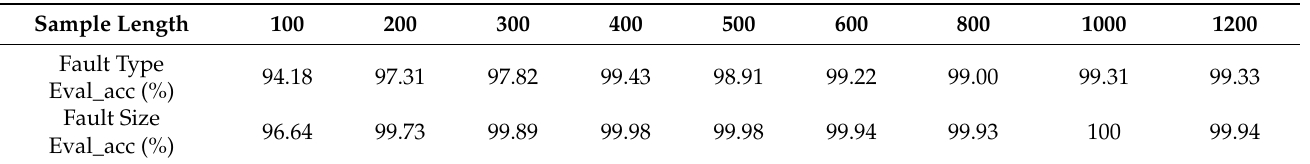
Table 5. Accuracy of subtasks.